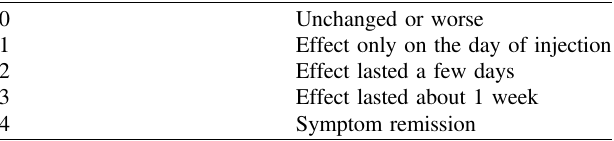
Table 1. Grading criteria for the evaluation of the duration and effectiveness of the intra-articular lidocaine injection on groin pain.